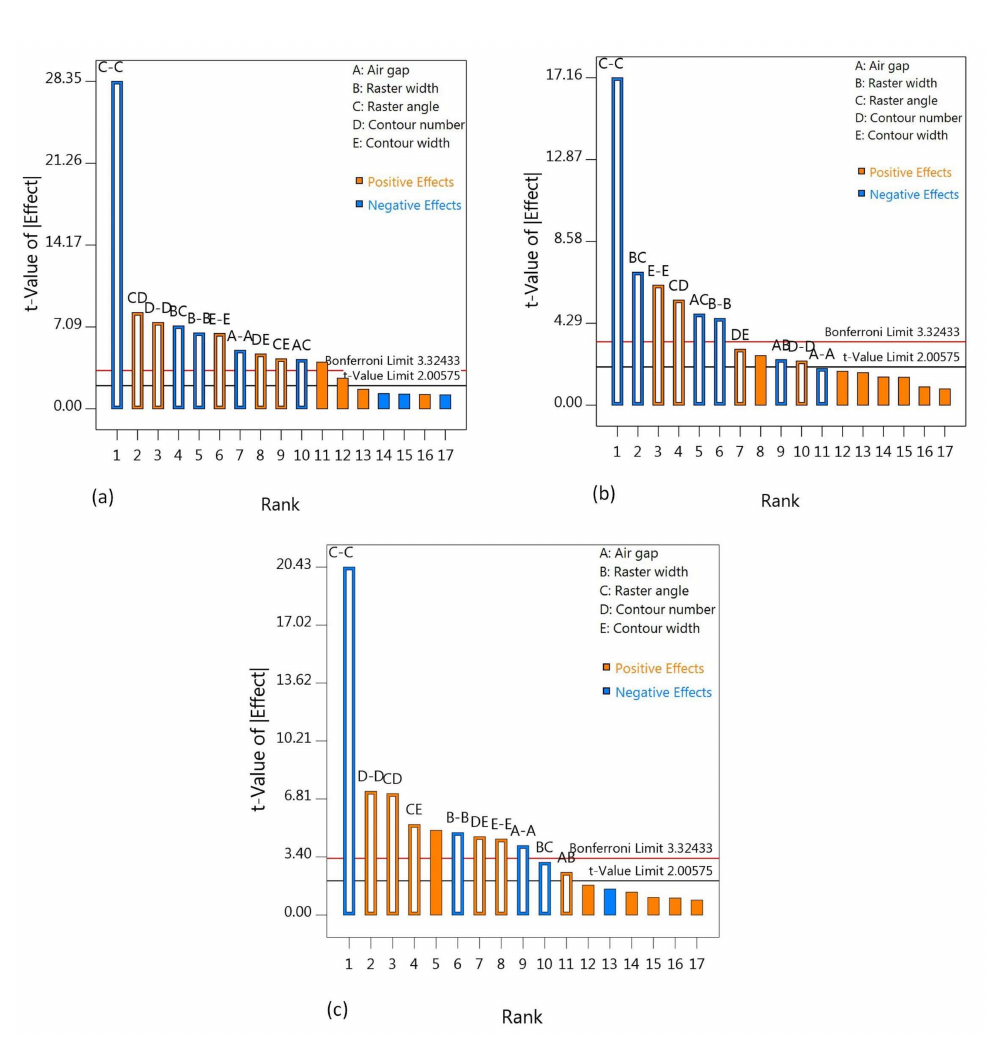
Figure 4. Factor screening using Pareto charts for ( a ) flexural strength; ( b ) modulus and ( c )